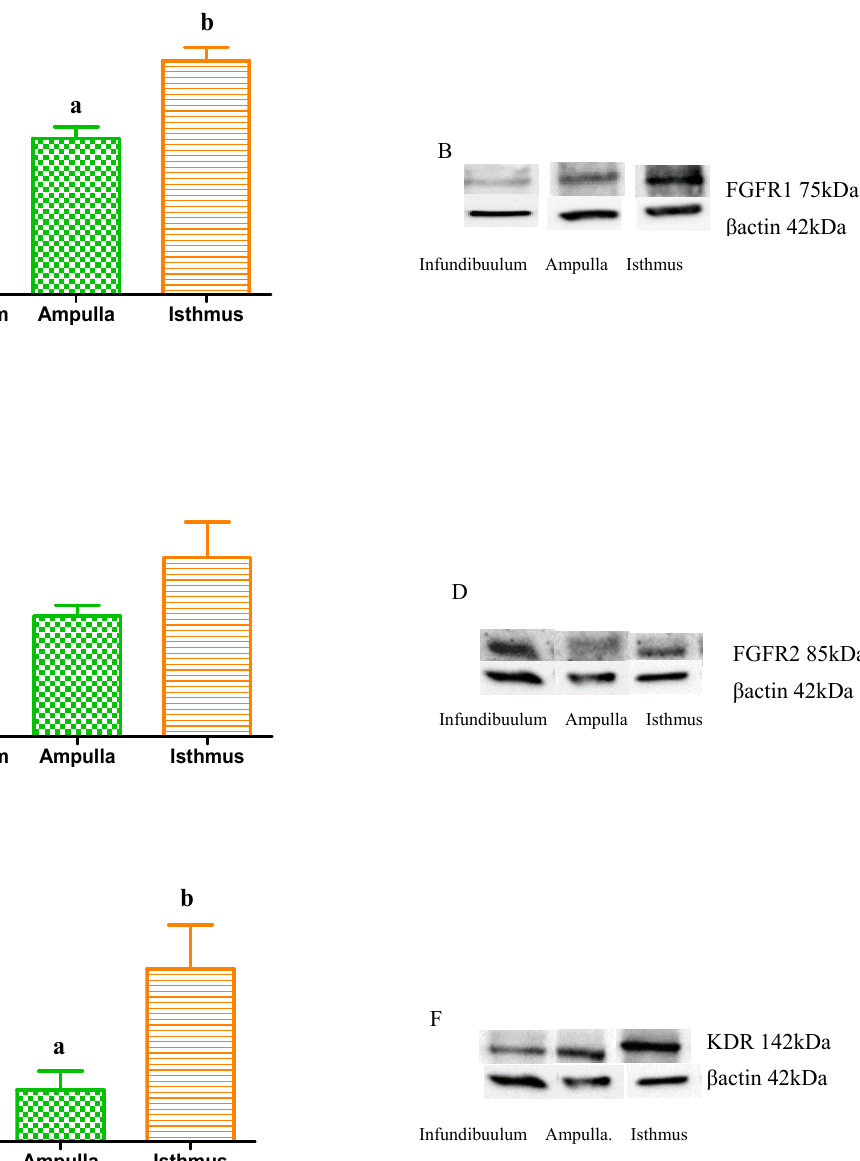
Figure 7. Relative protein abundance of FGFR1, FGFR2 and KDR in the equine oviduct ( n = 5 samples for each estrous cycle phase; n = 5 for each portion of oviduct analyzed). Comparison of relative protein abundance between oviduct portions (infundibulum, ampulla, isthmus), regardless of the phase of the estrous cycle ( A , C , D ), and their respective representative Western blot bands ( B , D , F ). Bars represent mean ± SEM. AU: arbitrary units. Different letters indicate significant differences ( p < 0.05).